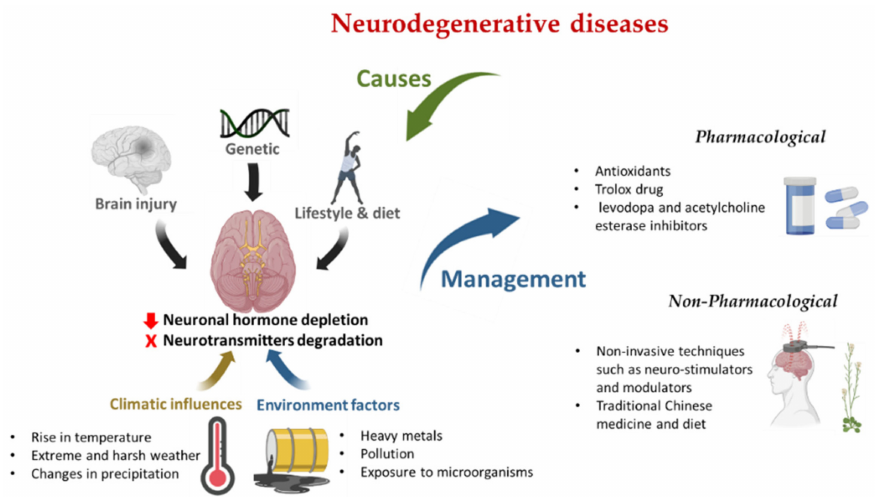
Figure 1. Summary of environment and climatic influences and approaches to manage NDDs Created by